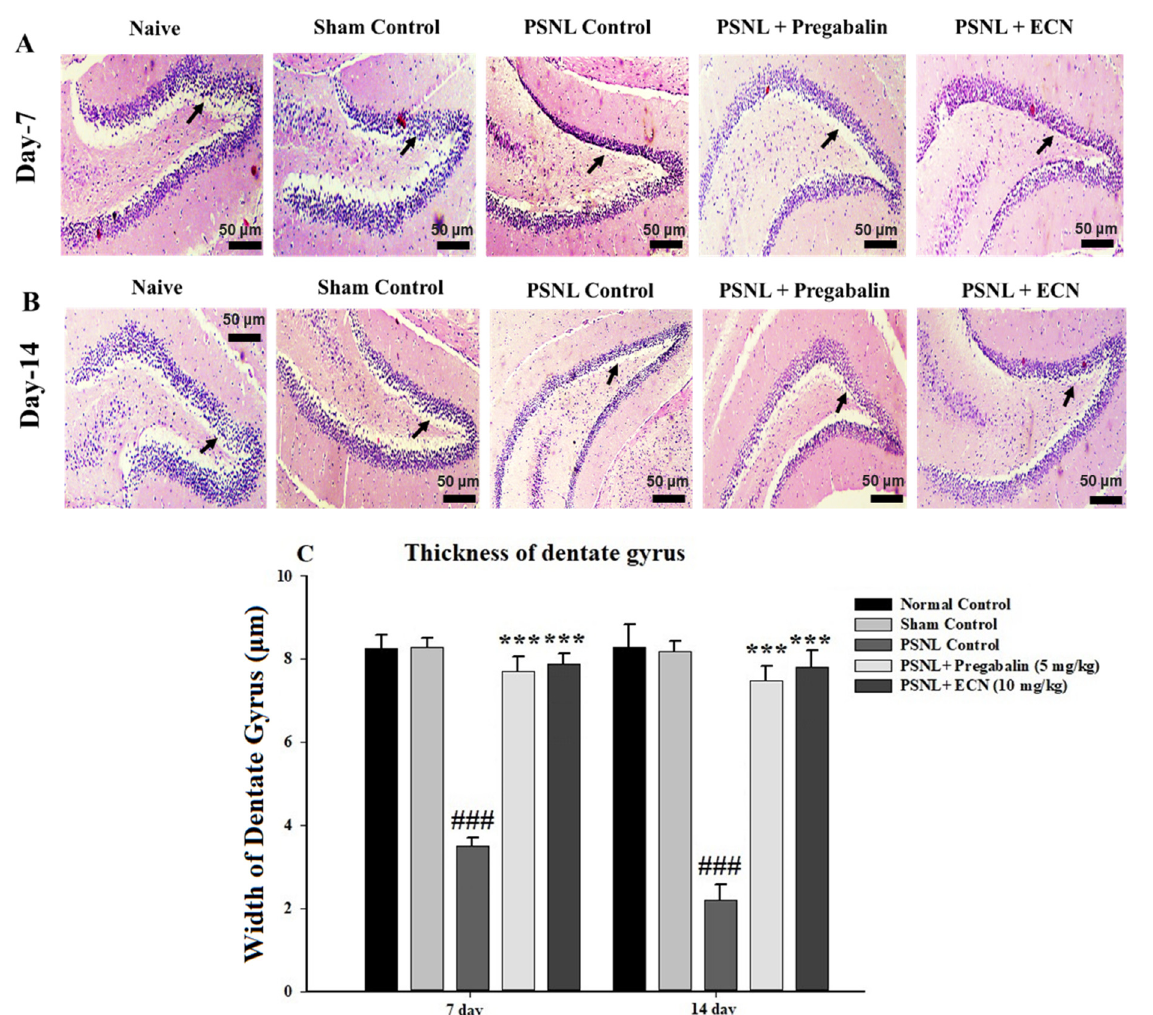
Figure 7. Effect of ECN (10 mg/kg) on the pathological histology of brain tissue, the dentate gyrus of mice subjected to PSNL is shown in coronal sections stained with hematoxylin and eosin at 10 × magnification (scale bar 50 µ m). ( A ) Pathological histology of brain tissue on day 7 post-PSNL surgery. ( B ) Pathological histology of brain tissue on day 14 post-PSNL surgery. ( C ) The thickness of dentate gyrus in micrometer ( μ m) on 7 and 14-day post-PSNL surgery. Black arrow heads show the thickness of the dentate gyrus. The data is presented as the mean (n = 3) ± S.D. Different letters meant statistically significant differences: (***) p < 0.001 indicate significant differences from the PSNL control group. (###) indicate significant differences from the normal control group. *** p < 0.001 (two-way ANOVA followed by Dunnett’s test).